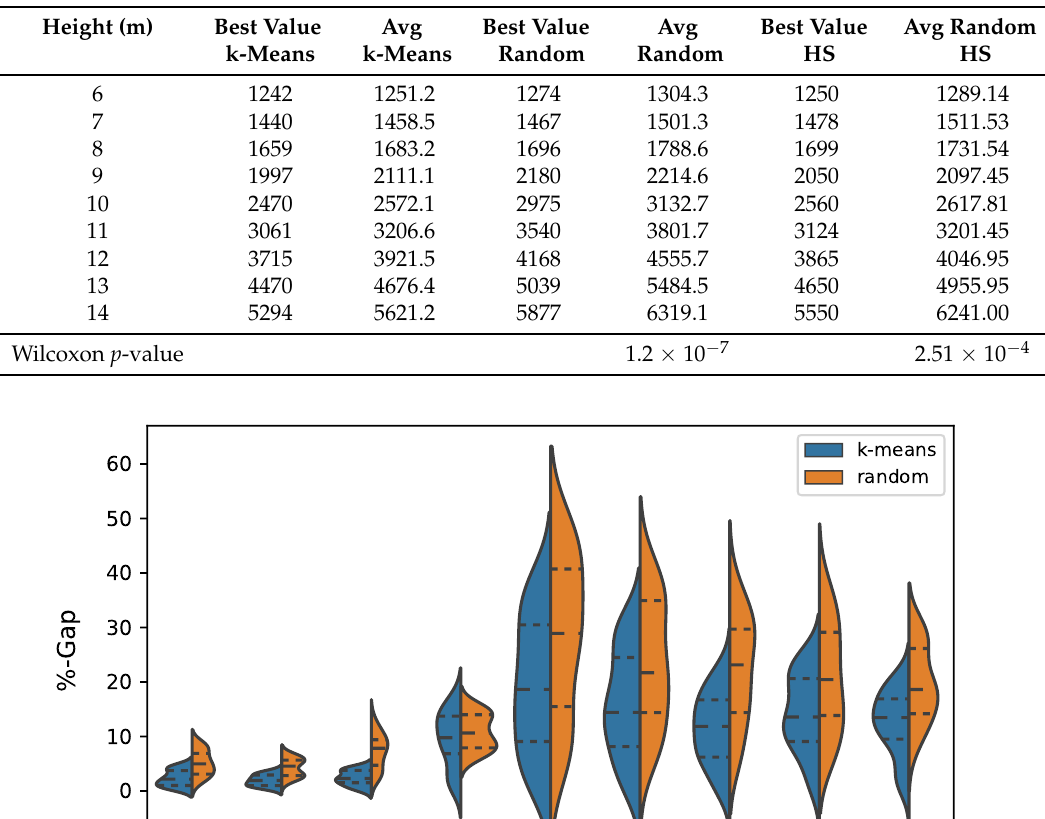
Figure 8. Cost violin plots, comparison between k-means and random operators. Table 6. Comparison between random and k-means operators in emission optimization.